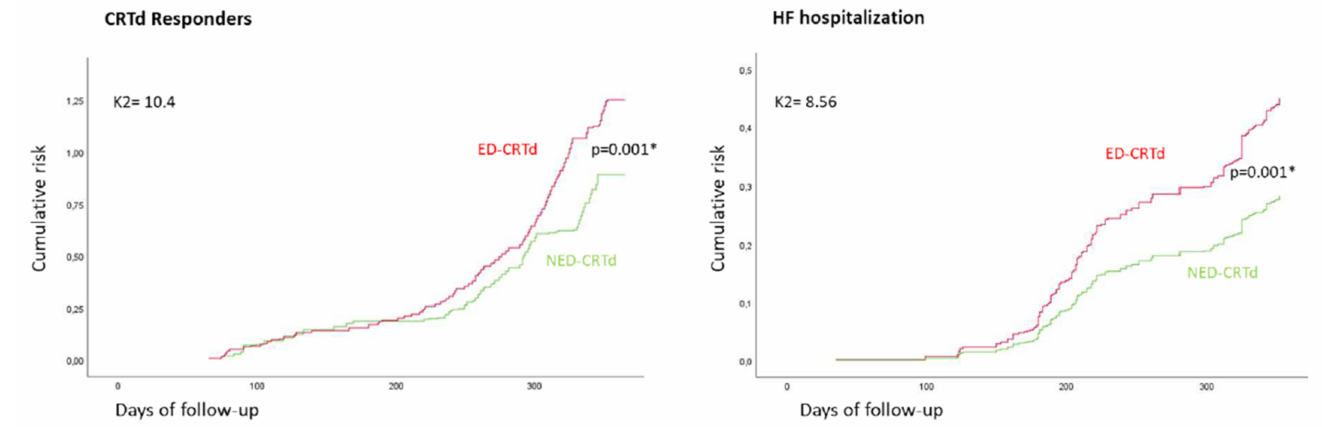
Figure 2. The Cox curves show the cumulative risk of study outcomes, being CRTd responders ( left part of figure ) and requiring HF hospitalizations ( right part of figure ) at 1-year follow-up in NED- CRTd (green) vs. ED-CRTd (red) patients. CRTd: cardiac resynchronization therapy; ED-CRTd: CRTd patients with endothelial dysfunction; NED-CRTd: CRTd patients without endothelial dysfunction. *: statistically significant, with p <